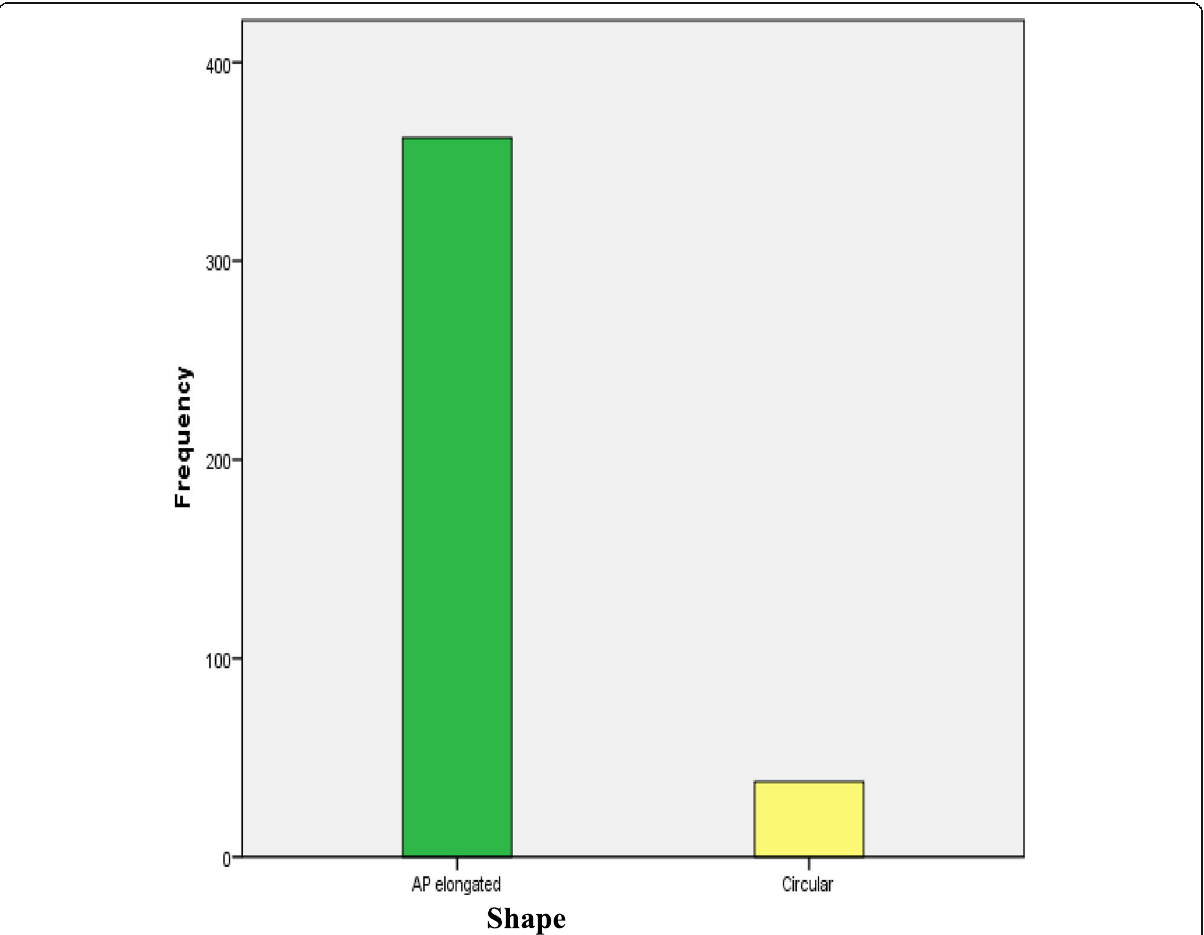
Fig. 8 Bar chart of the frequency of the shape of the greater palatine foramen (GPF) in CT scans